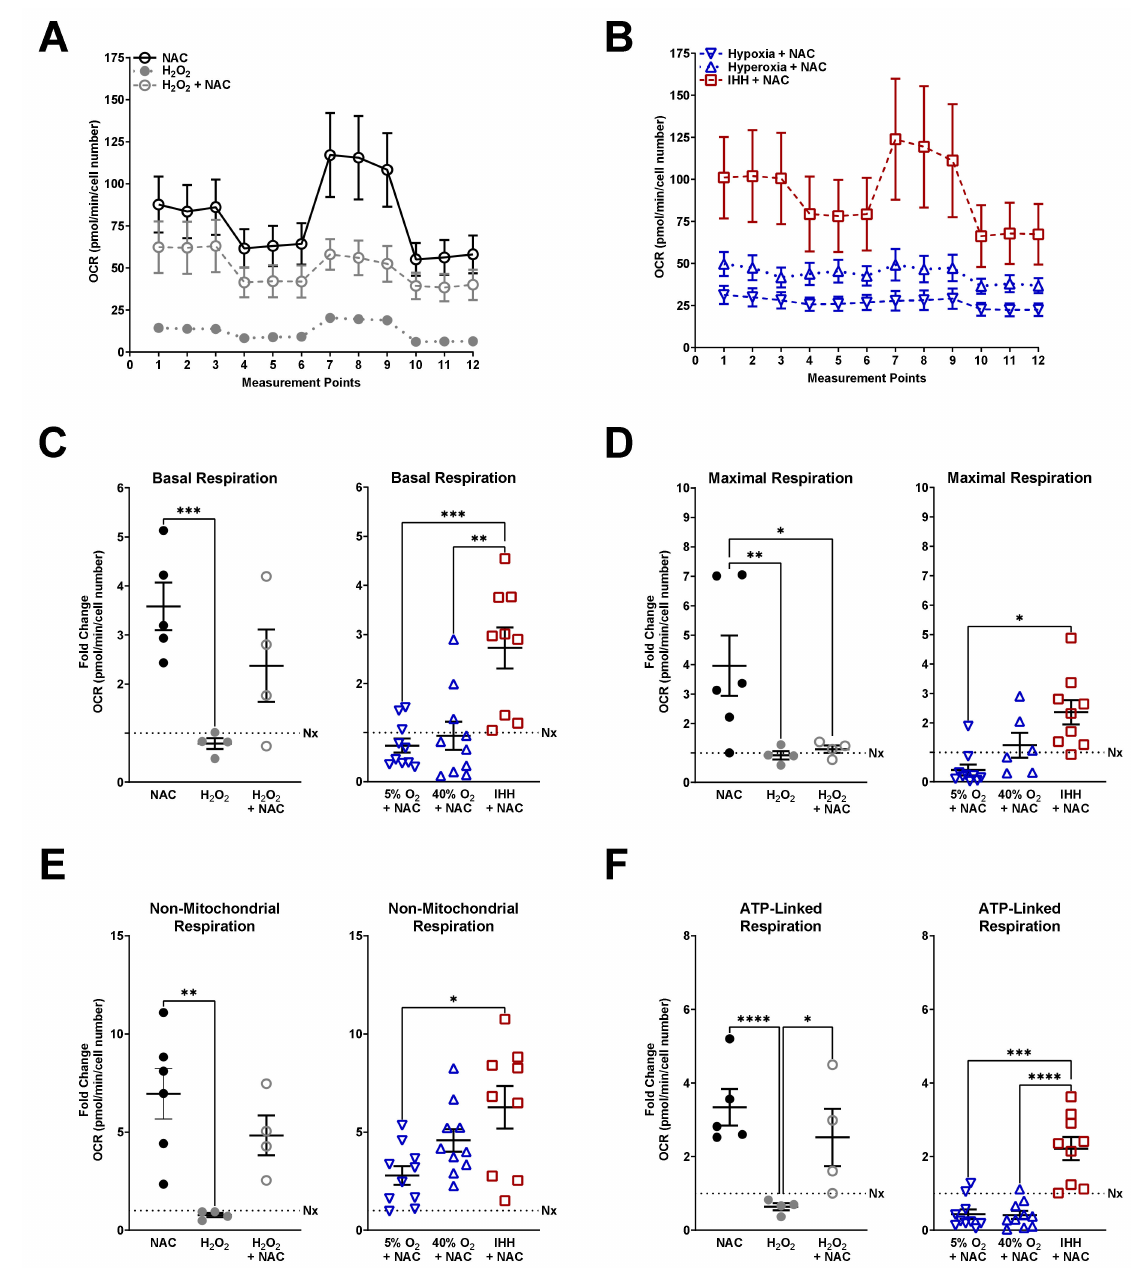
Figure 4. Mitochondrial respiration in fASM exposed to NAC. Mitochondrial stress test entails consecutive addition of oligomycin (inhibits ATP synthase), FCCP (uncouples ATP production), and rotenone + antimycin A (complex I and III inhibitors) and is measured by oxygen consumption rate (OCR) over time (measurement points). ( A ) Time-course of mitochondrial stress tests from normoxia fASM treated with either NAC alone (open black circles), H 2 O 2 alone (closed gray circles), or NAC + H 2 O 2 (open gray circles) for 2 h prior to mitochondrial stress test. ( B ) Time-course of mitochondrial stress tests from fASM exposed to either 5% O 2 , 40% O 2 , or IHH treated with NAC for 24 h prior to assaying. ( C ) Basal respiration, ( D ) non-mitochondrial respiration, ( E ) maximal respiration, ( F ), and ATP-linked respiration were calculated from data generated on the Seahorse. NAC = open black circles; H 2 O 2 = closed gray circles; H 2 O 2 + NAC = open gray circles; hypoxia + NAC = upside-down open blue triangles; hyperoxia + NAC = right-side-up open blue triangles; IHH + NAC = open red squares. Data were analyzed using one-way ANOVA: * p < 0.05; ** p < 0.05; *** p < 0.001; **** p < 0.0001. Data are represented as mean ± SEM ( n = 3 fASM patient lines per condition per group; scatter plots include 6–8 technical replicates from three patient